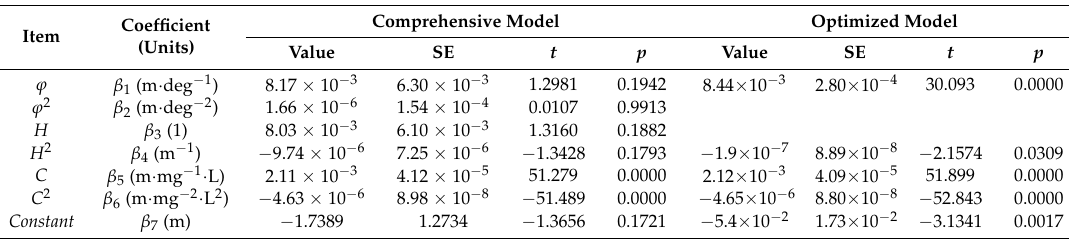
Table 4. Coefficients and their significances to the comprehensive and optimized models. SE: standard error; t : t -statistics.